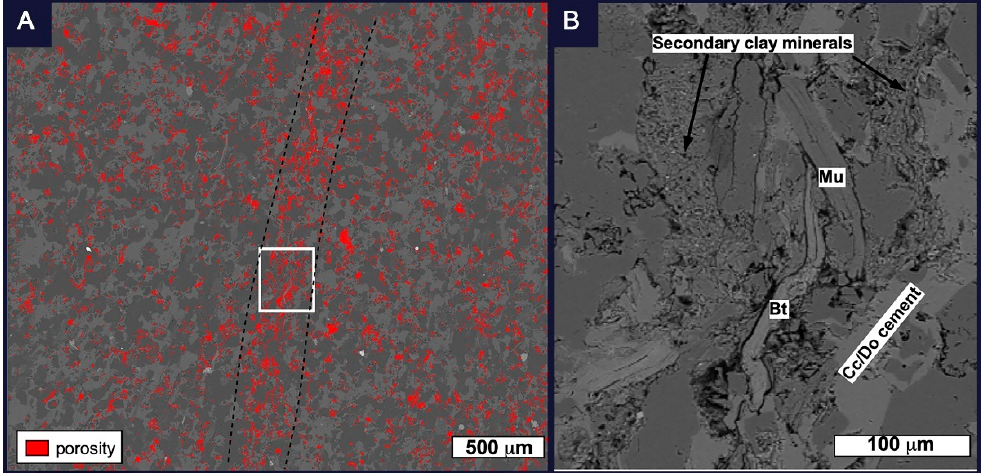
Figure 12. ( A ) Backscattered electrons (BSE) SEM with an overlapped porosity mask highlighting the preferential pore concentration along laminations (dashed lines). ( B ) Enlarged view of the lamination (white rectangle in A ) showing the textural relationships of primary phyllosilicates and secondary clay minerals with respect to clastic particles and carbonate cement. Bt = biotite; Mu= muscovite; Cc = calcite; Do = dolomite.